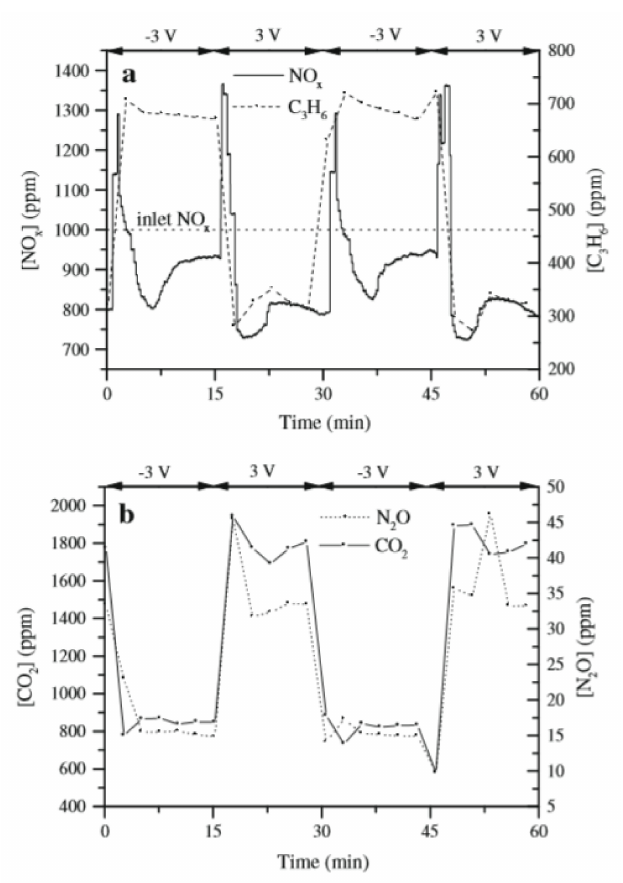
Figure 4. NO x , C 3 H 6 ( a ), N 2 O and CO 2 ( b ) outlet concentration profiles vs. time during NO x storage / reduction tests with a tubular Pt / K + - β ”Al 2 O 3 / Pt electrochemical reactor. Fixed lean reaction conditions: 1000 ppm NO, 1000 ppm C 3 H 6 , 5% O 2 (He balance), 320 ◦ C. NO x storage step: − 3 V, NO